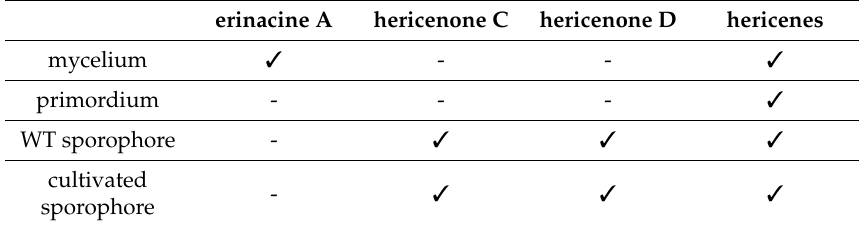
Figure 8. UV traces of primordium (top) and hericenones C and D standards (bottom). Table 4 summarizes the array of metabolites present in di ff erent stages of H. erinaceus . Table 4. Presence of di ff erent molecules (erinacine A, hericenones C and D, and hericenes) in the lyophilized mycelium, fresh primordium, and dried sporophores.